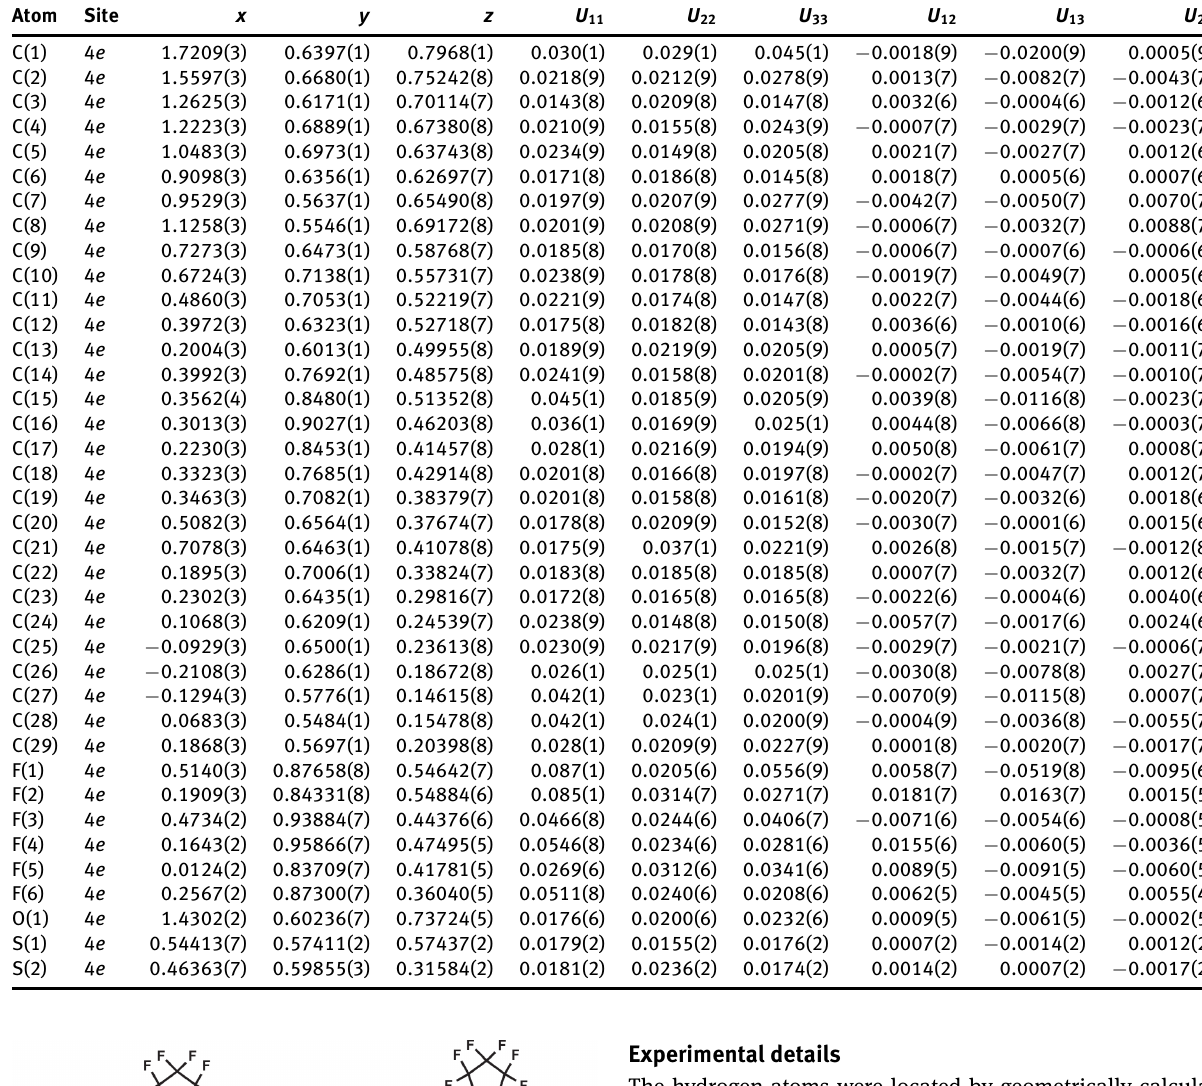
Table 3: Atomic displacement parameters (Å 2